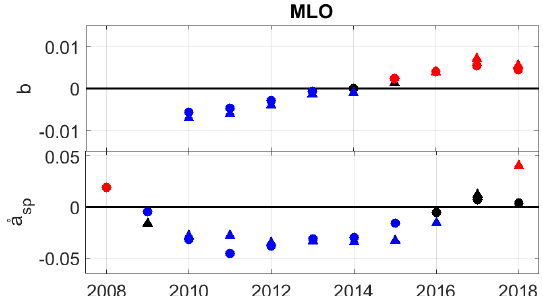
Figure 18. 10-year slopes of b and å sp at MLO. Ss negative and positive trends are plotted in blue and red, respectively. Not ss trends are plotted in black. The dots correspond to PM 10 and the upwards triangles to PM 1 .